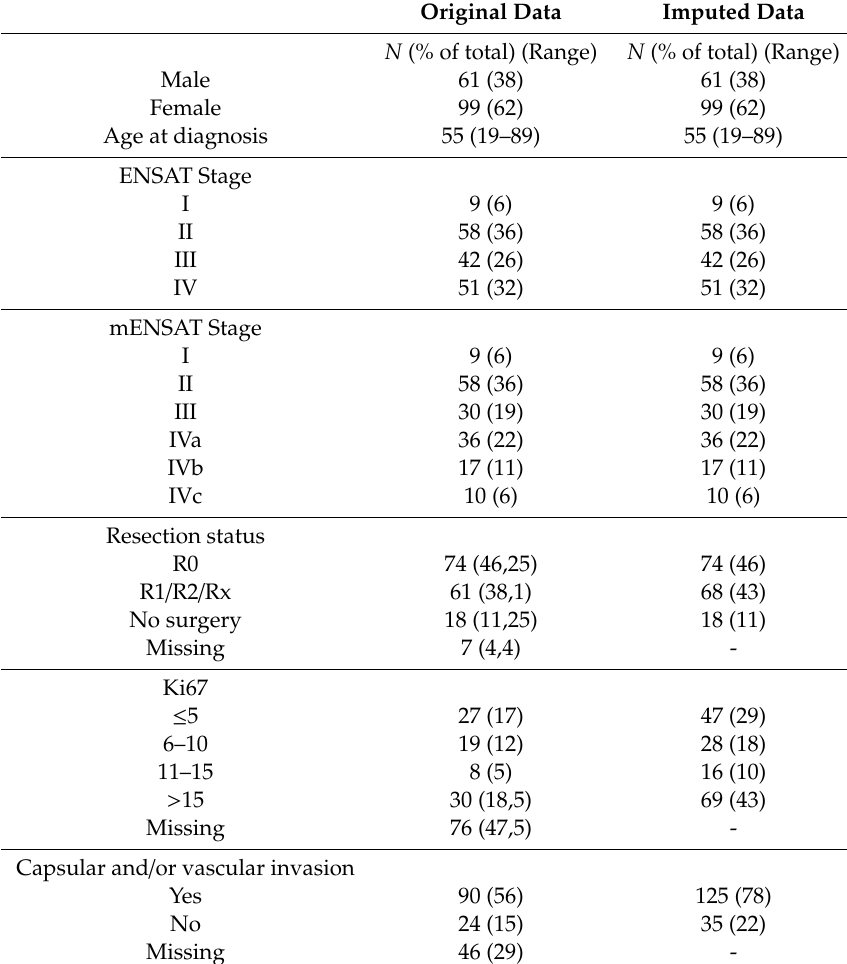
Table 1. Patient characteristics ( N = 160)